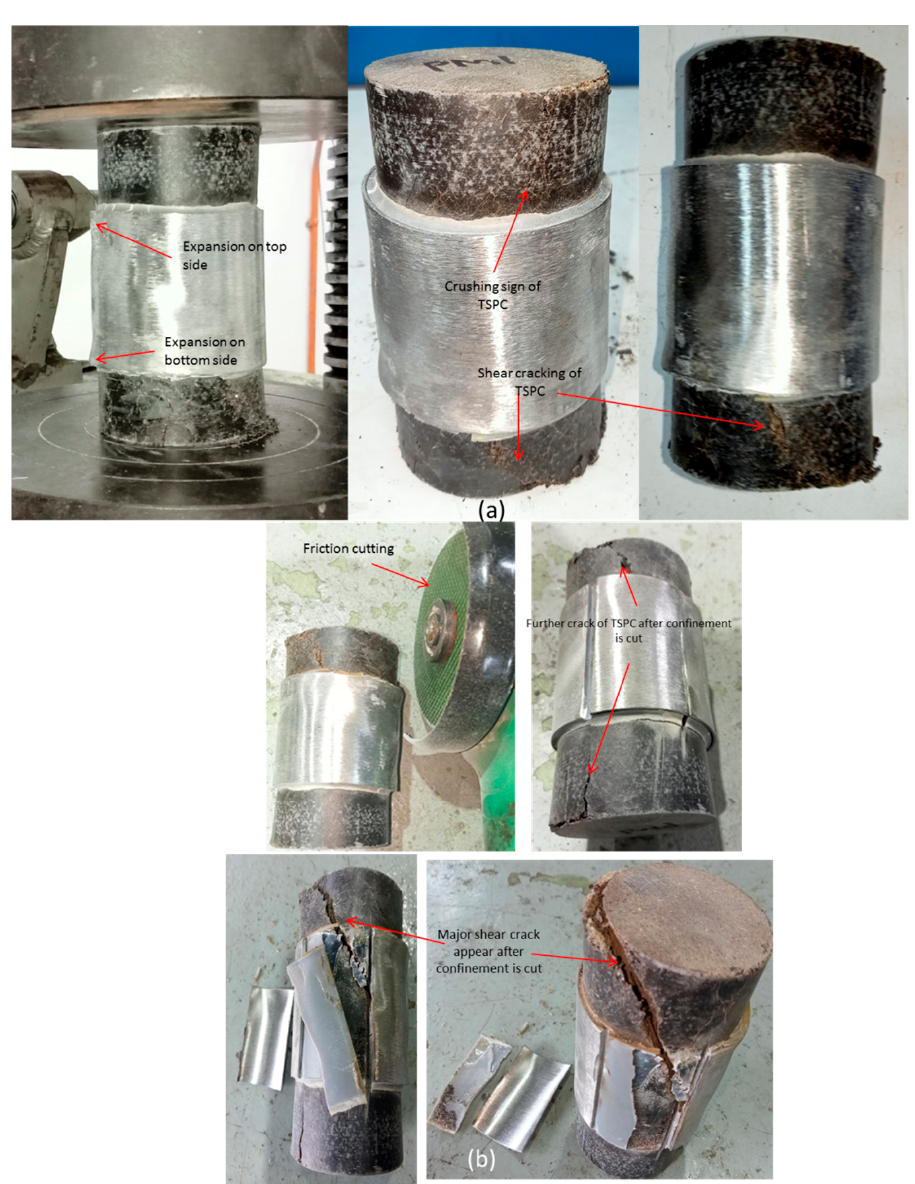
Figure 11. Failure modes of TSPC with partial metal tube confinement. ( a ) PM sample condition after mechanical testing. ( b ) PM sample with bottom side view and the cut open of confinement for failure examination.